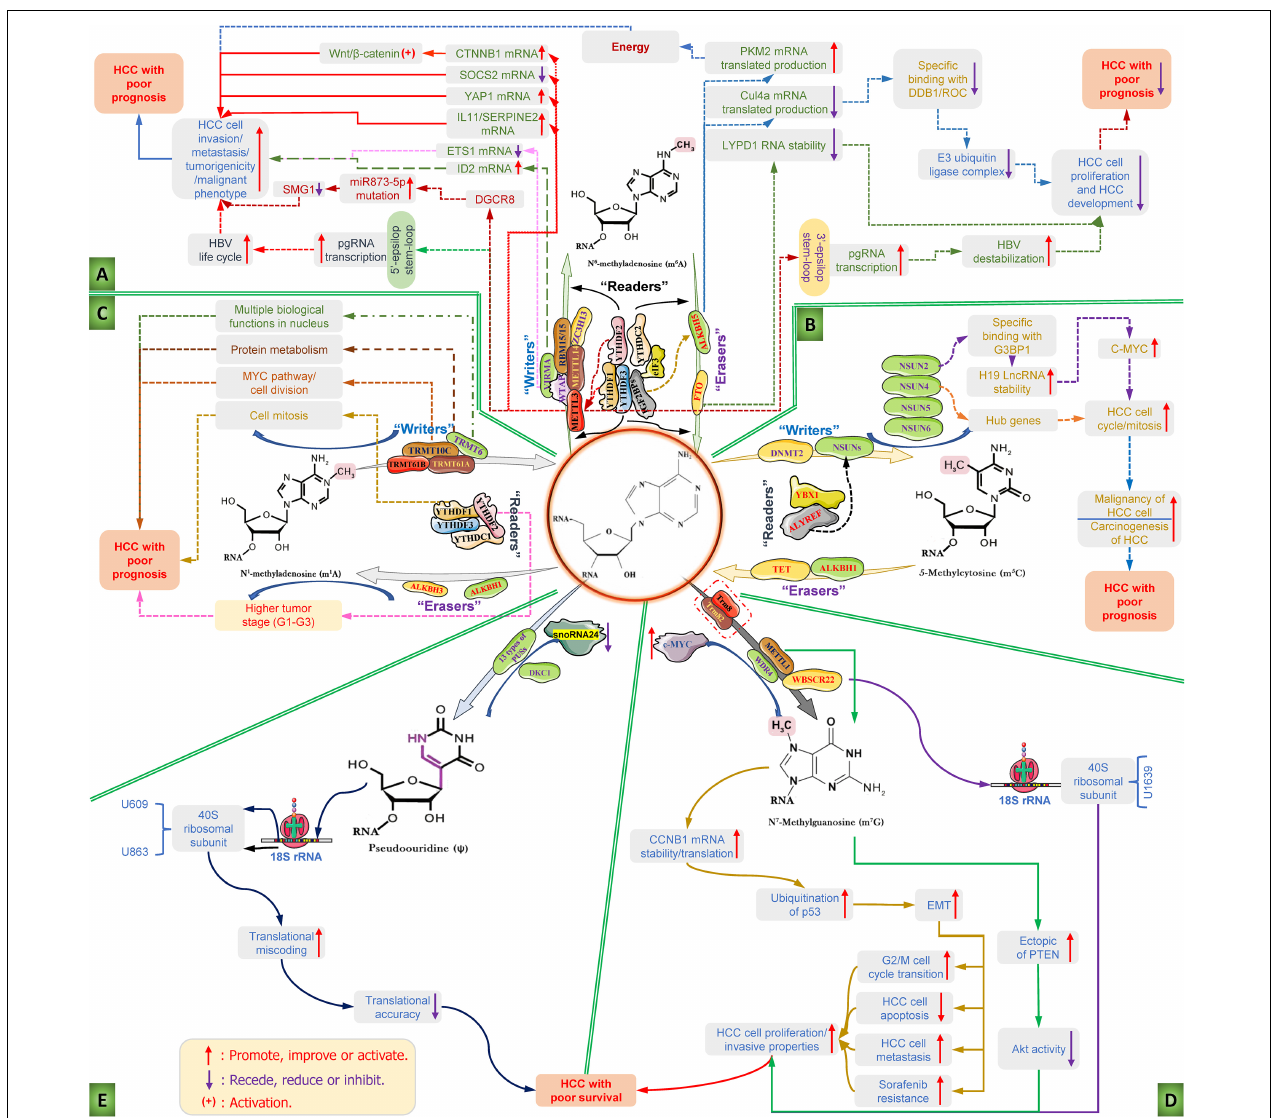
FIGURE 2 | Diverse RNA epigenetic modifications and their functions in the carcinogenesis and progression of hepatocellular carcinoma. RNA epigenetic modifications, including N6-methyladenosine (m6A), 5 methylcytosine (m5C), N1-methyladenosine (m1A), N7-methylguanosine (m7G), and pseudouridine ( ψ ), have been reported to play major roles in the invasion, metastasis and malignant transformation of HCC cells and the progression of HCC. (A) The mechanism diagram mainly illustrates the roles of the dysfunction of RNA m6A modification regulators and the corresponding m6A modifications regulates the key influencing factors and the whole course of HCC development; (B) the detailed roles of RNA m5C modification regulators dysfunction and the corresponding m5C modifications regulates the carcinogenesis and progression of HCC; (C) deregulation of m1A modifiers and the related RNA m1A modifications in the carcinogenesis and progression of HCC; (D) deregulation of m7G modifiers and the related RNA m7G modifications in the development features of liver cancer cell and carcinogenesis and progression of HCC; and (E) role of pseudouridine ( ψ )-mediated pseudouridylation of 18S rRNA in the HCC with poor survival. ALKBH1/3/5, AlkB homolog 1/3/5; ALYREF, Aly/REF export factor; C-MYC, MYC proto-oncogene; CTNNB1, catenin (cadherin-associated protein), beta 1; CUL4A, Cullin 4A; DDB1, DNA damage binding protein 1; DGCR8, DiGeorge critical region 8; DKC1, Dyskerin pseudouridine synthase 1; DNMT2, DNA methyltransferase; elF3, E74-like factor 3; EMT, Epithelial-to-mesenchymal transition; ETS1, ETS proto-oncogene 1; FTO, fat mass and obesity-related protein; G3BP1, Ras GTPase-activating protein-binding protein 1; HBV, hepatitis B virus; HCC, hepatocellular carcinoma; HCV, hepatitis C virus; IGF2BP1/2/3, insulin like growth factor 2 mRNA binding protein 1/2/3; IL11, interleukin 11; lncRNA, long non-coding RNA; LYPD1, LY6/PLAUR Domain Containing 1; m1A, N1-methyladenosine; m5C, 5-methylcytosine; m6A, N6-methyladenosine; m7G, N7-methylguanosine; METTL3/14, methyltransferase-like 3/14; NSUN2/4/5/6, NOP2/Sun domain family, member 2/4/5/6; pgRNA, pregenomic RNA; ψ , pseudouridine; PKM2, Pyruvate kinase type M2; PTEN, Phosphatase and tensin homolog; RBM15/15B, RNA binding motif protein 15/15B; SERPINE2, serpin family E member 2; SMG1, suppressor with the morphological effect on genitalia 1; snoRNA24, Small nucleolar RNA 24; SOCS2, suppressor of cytokine signaling 2; TET, Ten-eleven translocation methyl-cytosine dioxygenase; TRMT, Transfer RNA methyltransferase; TRUB1, TruB PSU class members 1; VIRMA, Vir-like m6A methyltransferase with association; WBSCR22, Williams-Beuren syndrome chromosome region 22; WDR4, WD repeat domain 4; WTAP, Wilms tumor 1-associating protein; YAP1, Yes1 associated transcriptional regulator; YBX1, Y-box binding protein 1; YTHDC, YTH domain-containing reader protein; YTHDF, YT521-B homology domain family; ZC3H13, zinc finger CCCH-type covering 13.